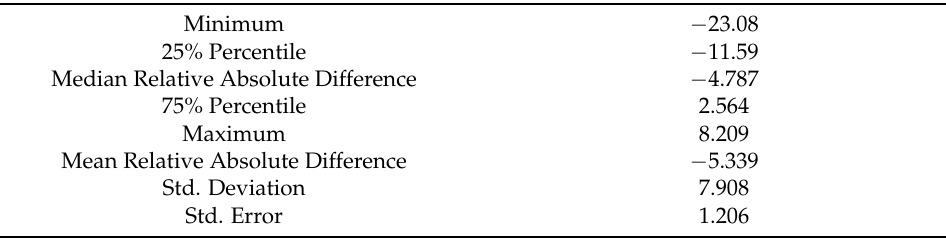
Table 1. Relative absolute difference between HGR glucose meter and relative core lab glucose values.